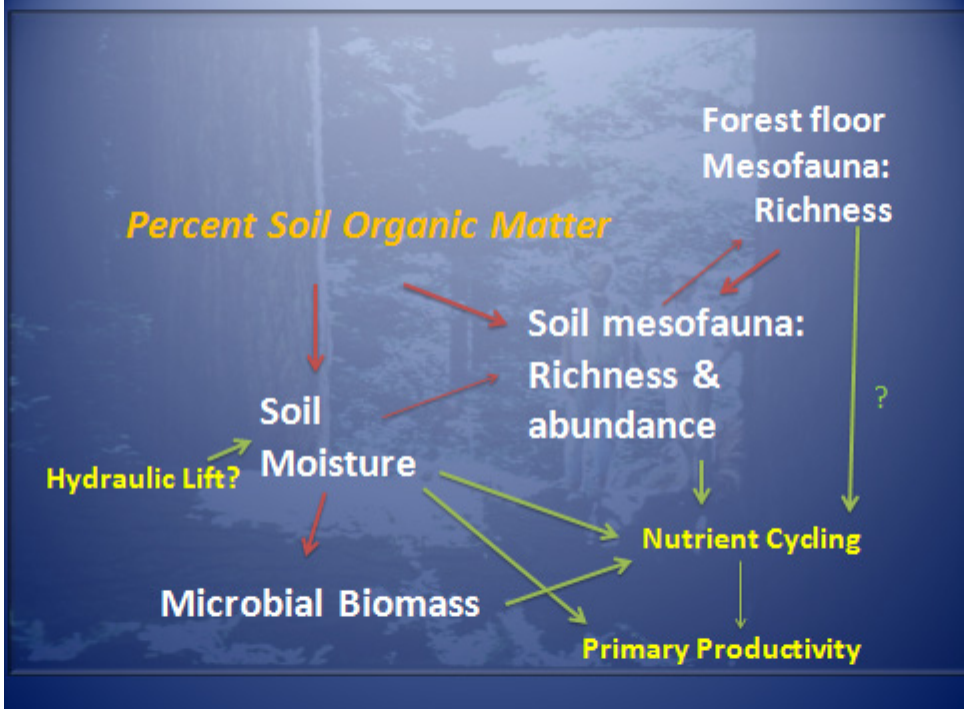
Figure 11. Summary of multivariate relationships. Variables that separate old growth from mature stands in the most significant multivariate analyses of covariance are denoted in white. (Microbial biomass was measured by anaerobic mineralizable nitrogen). Red arrows denote statistically significant relationships quantified in this study, Variables in yellow with green connecting arrows indicate relationships not measured in this study but well established in the literature (except the connection between forest floor mesofauna and nutrient cycling, which needs more study). The question mark follows hydraulic lift because we do not know how much it may have contributed to soil moisture in this study, but evidence suggests it was a